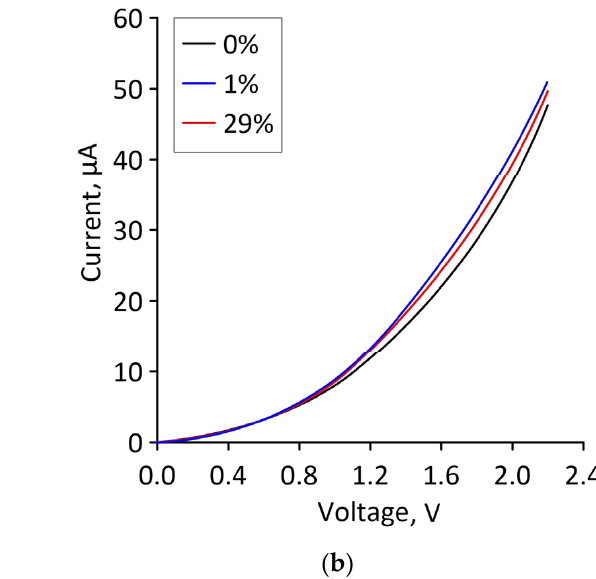
Figure 9. Current-voltage characteristics of bilayer graphene-SW С NT (12,6) hybrid fi lms with island topology for various cases of axial compression: ( a ) model V1; ( b ) model V2.